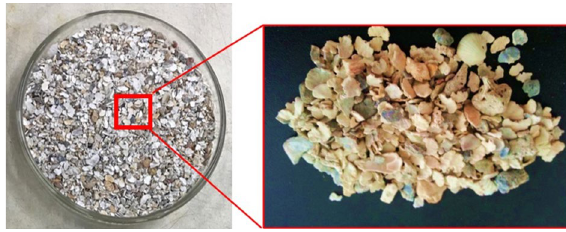
Figure 1. Halimeda grains, shell fragments, and reefs.